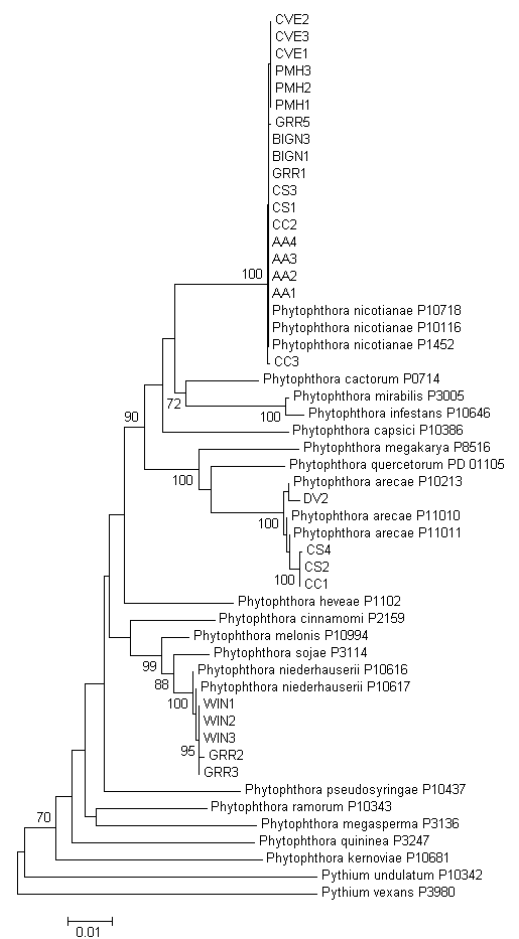
Figure 2. Molecular phylogenetic neighbour-joining tree based on elongation factor 1 alpha and β-tubulin DNA se- quence data from 27 Phytophthora isolates collected from ornamental host species in Italy. Three reference strains for each species were also included, along with one refer- ence strain from each Phytophthora clade (Blair et al. 2008) and two Pythium species as outgroups. Bootstrap values are shown at branch nodes, and branch lengths represent the number of substitutions per